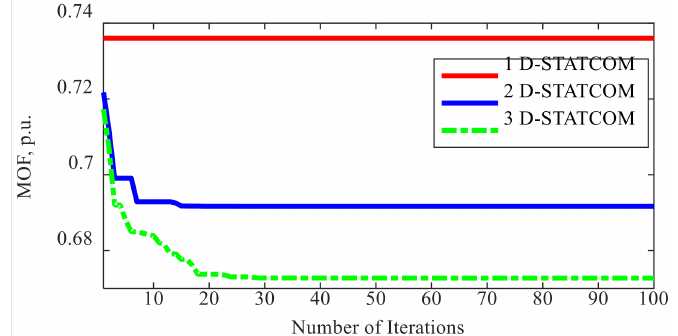
Figure 12. Convergence characteristics for OADS in 51-bus